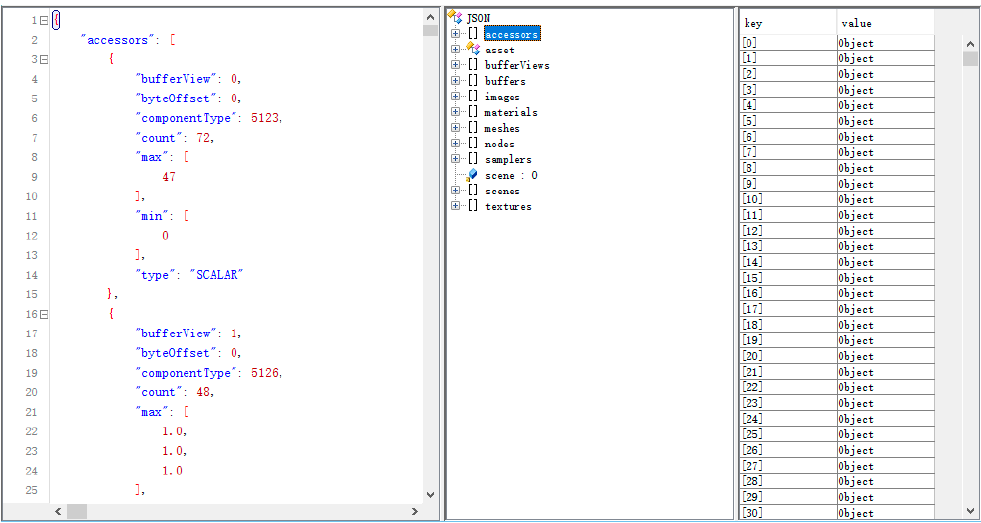
Figure 9. JSON file information.